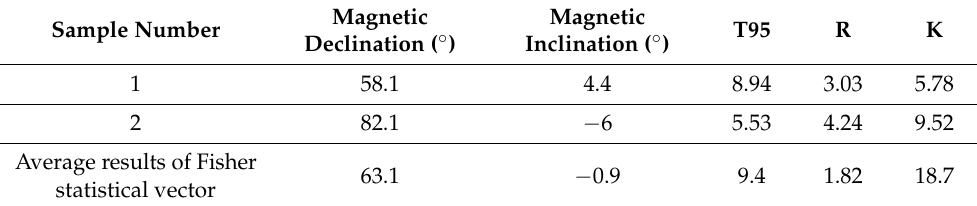
Figure 8. Photo of palaeomagnetic core sample. Table 2. The results of characteristic remnant magnetization measurements.